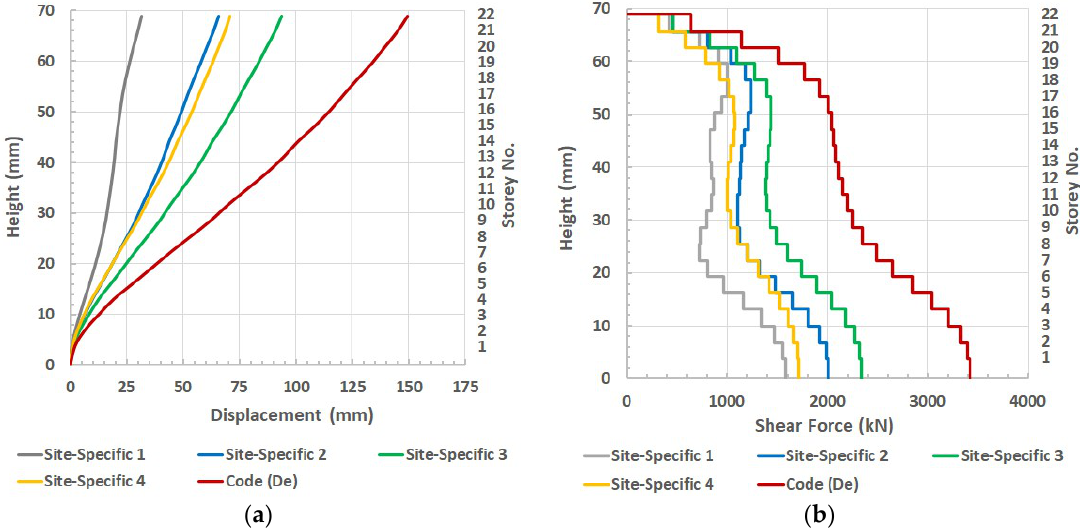
Figure 8. Storey displacement and storey shear results for CSB 2: ( a ) storey displacement and ( b ) storey shear. Table 3. Modal periods (Tn) and mass participation (MP) for the case study buildings.